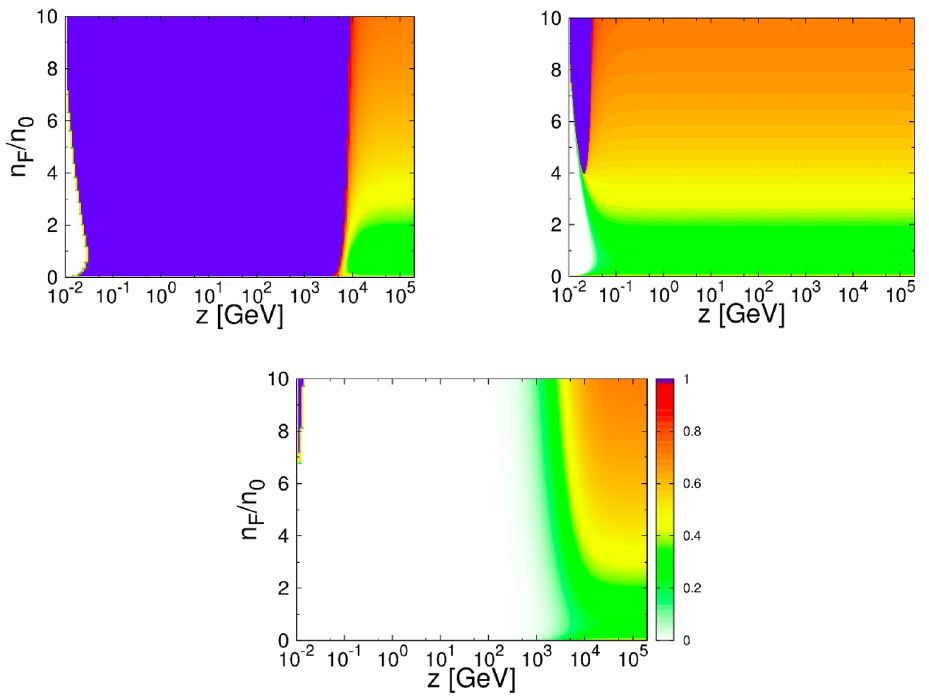
Figure 4 . Same as (cid:12)gure 3, but including DM self-energy and for z=z 0 ’ 2 (cid:2) 10 5 . Upper-Left panel: attractive DM self-energy (cid:0) n panel: repulsive DM self-energy + n